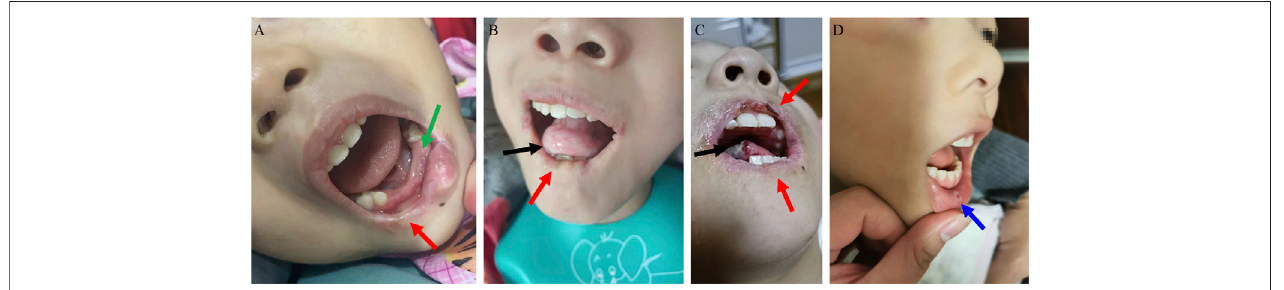
FIGURE 1 | Self-mutilation symptoms in LND. (A) : Patient 2 ’ s right lower lip became thinner (red arrow) due to his bite, and the lower central and lateral incisors were also worn away by himself (green arrow). (B) : Patient 1 ’ s lower lip became thinner (red arrow), and the tongue became shorter due to long-term self-injurious behaviour (SIB). (C) : Patient 6 ’ s lip became mutilated due to SIB (red arrow), and the tip of his tongue was often battered by his bite (black arrow). (D) : Bitting of the mucosa in patient 8 (blue arrow).